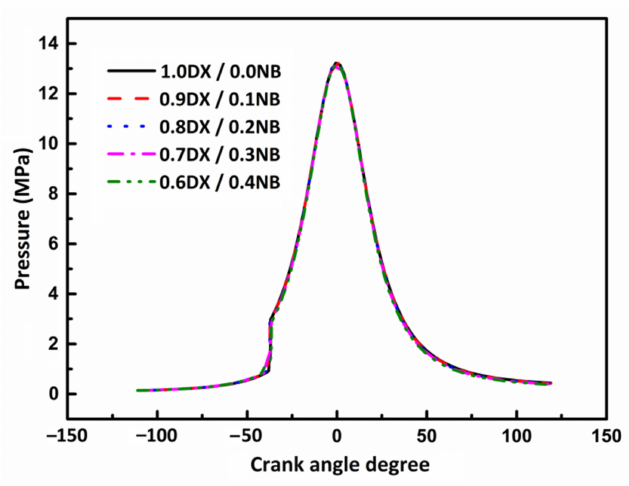
Figure 11. Effect of DX and n-butanol mixing ratio on combustion pressure in